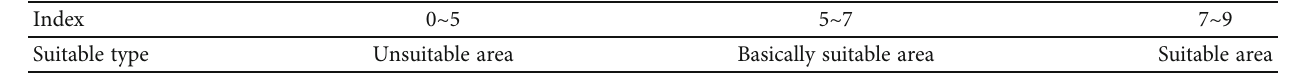
Table 6: Suitability classi fi cation index of the groundwater source heat